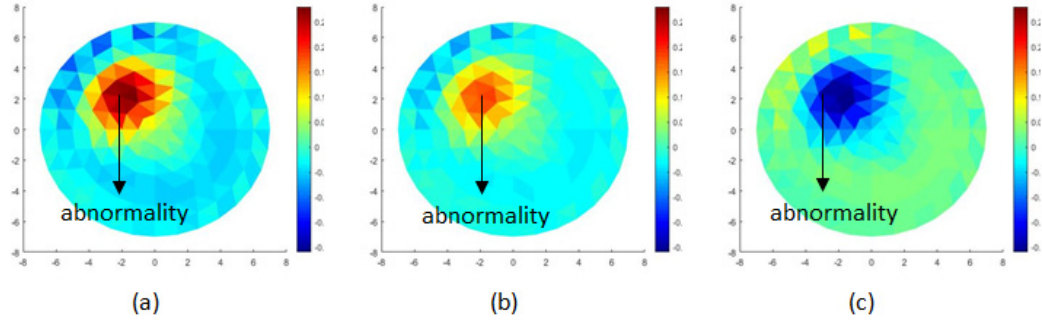
Figure 18. ( a ) Impedance functional image, ( b ) real functional image, ( c ) imaginary functional image.